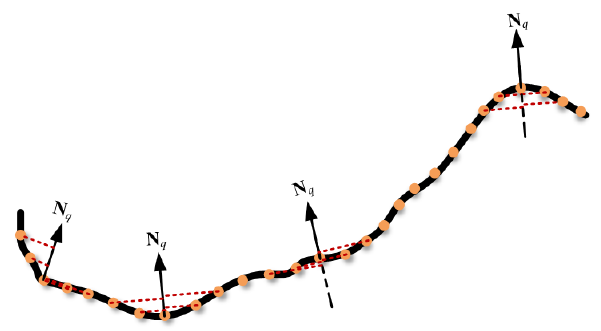
Figure 1. Convexity measure: the neighboring points are projected onto the center point normal direction n q